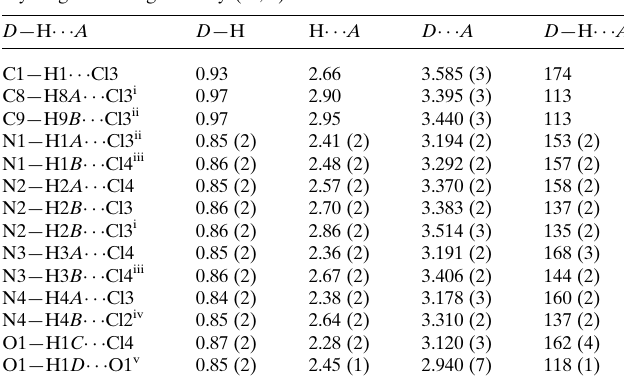
Table 1 Hydrogen-bond geometry (A˚ , (cid:5) ).